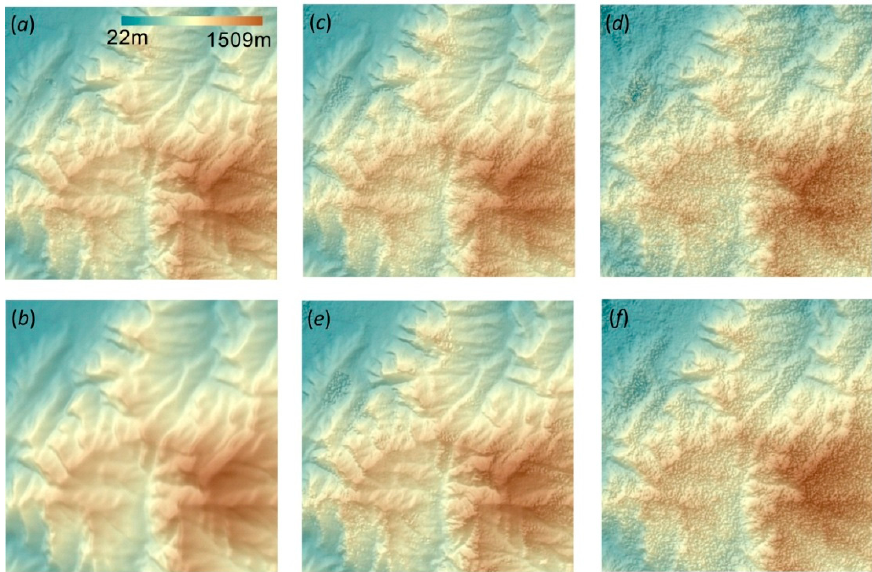
Figure 9. Hillshades of single/multi-baseline DEMs and SRTM DEM corresponding to the black rectangle in Figure 8a. ( a ) Multi-baseline InSAR DEM; ( b ) radar-coded SRTM DEM; ( c ) Interferogram I DEM, h 2 π = 82 m; ( d ) Interferogram II DEM, h 2 π = 833 m; ( e ) Interferogram III DEM, h 2 π = 115 m; ( f ) Interferogram IV DEM, h 2 π = 347 m.